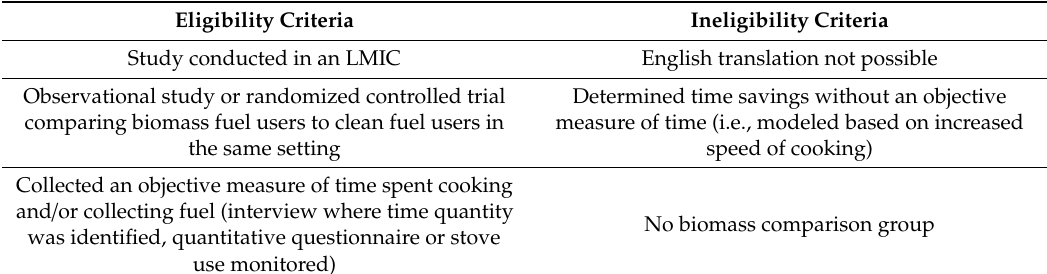
Table 1. Eligibility criteria. LMIC: Low- and / or middle-income